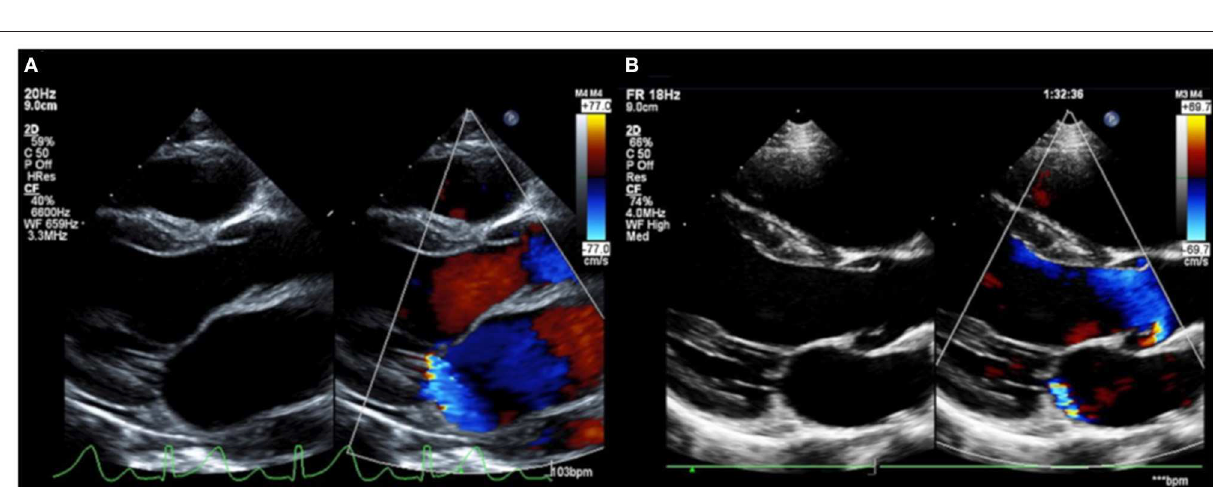
FIGURE 2 | First-degree atrioventricular block detected on electrocardiography at the 1-year follow-up of Kawasaki disease.